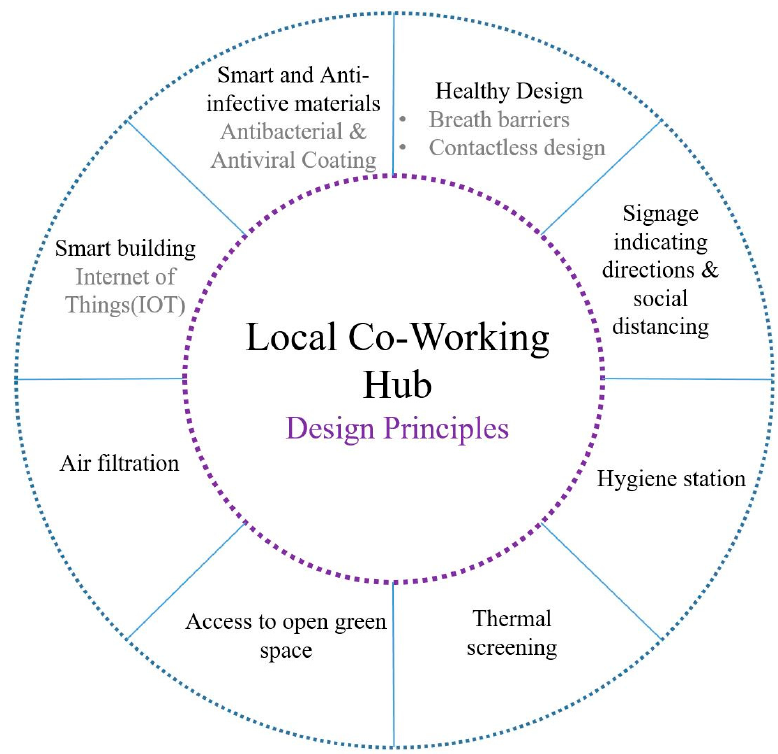
Figure 4. Proposed design principles for local co-working hubs.